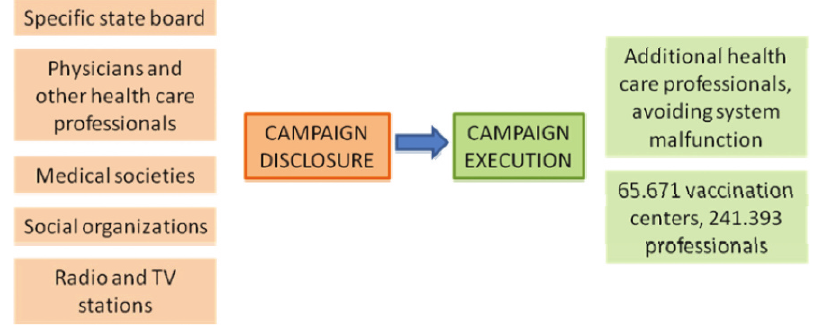
Figure 1 - Strategies that were adopted by the Brazilian government to promote and maintain influenza vaccine coverage among older persons. Adapted from the National Influenza Immunization Campaign Targeting Older Persons Technical Report, Brazil, Ministry of Health, 2007. 9